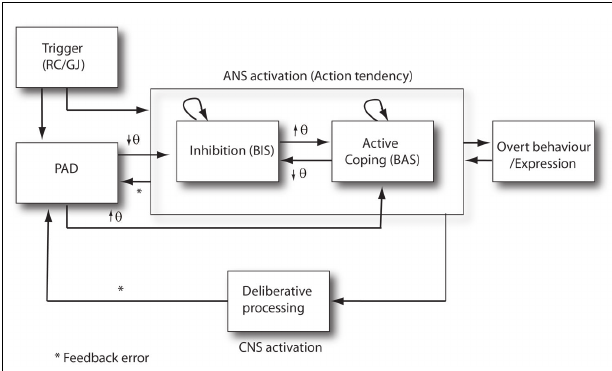
FIGURE 7 | Schema of emotion regulation of goal-directed behavior. Following Figure 3 , PAD (pleasantness, arousal, dominance) has a key regulatory effect on action tendency and is a fundamental component of the full emotion episode. Feedback, in the case of suprathreshold activity may produce acceptability / availability mismatch errors, or in the case of subthreshold activity, galvanize neural activation that comes to represent the action tendency. See main text for